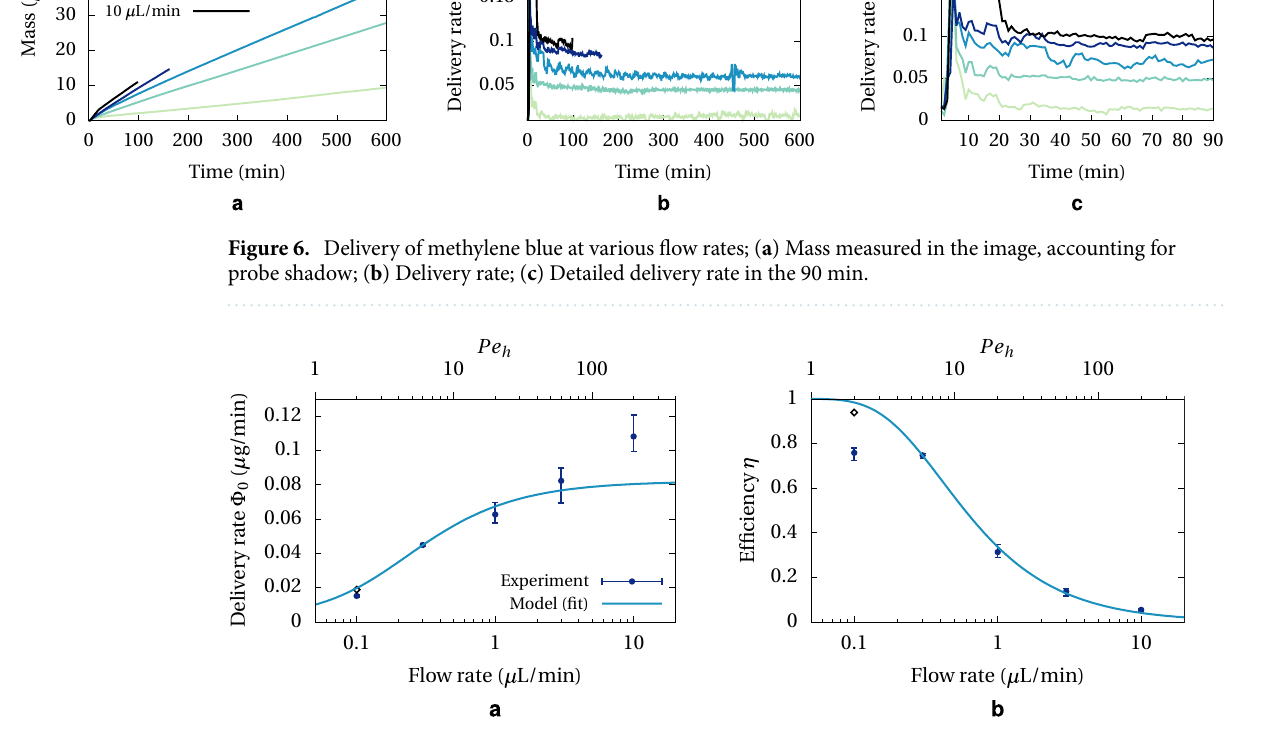
) • ) shows an experiment with ⋄